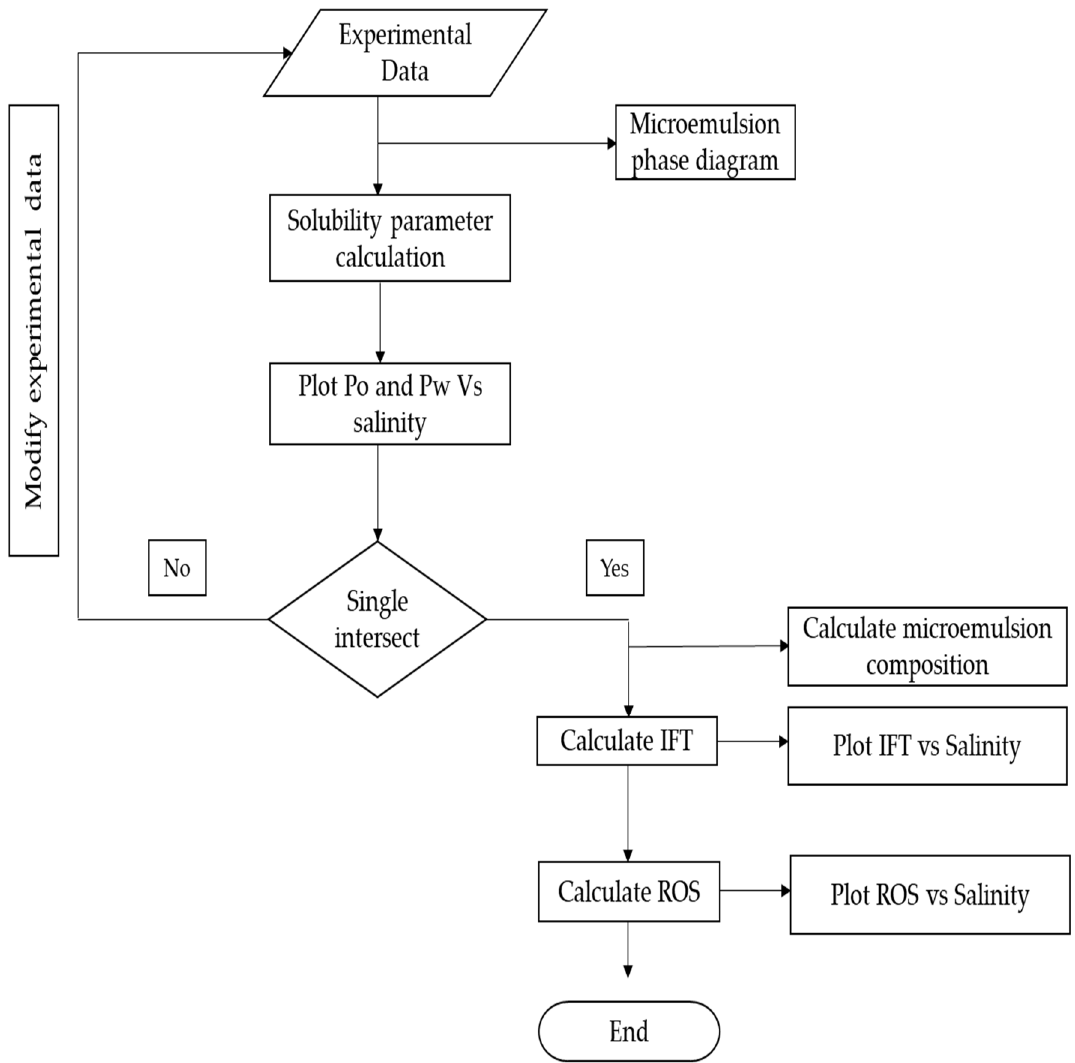
Figure 4. Model workflow diagram.